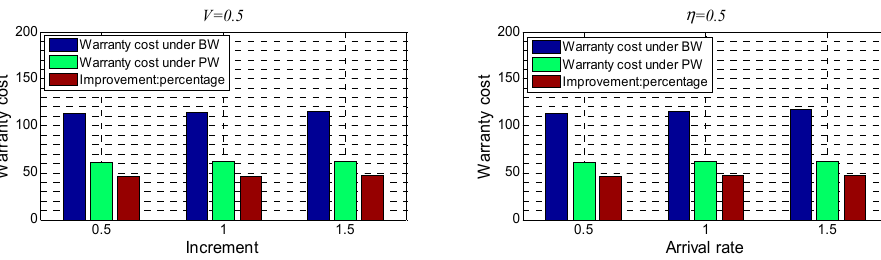
Figure 5. The effect of the shock process on the warranty cost.